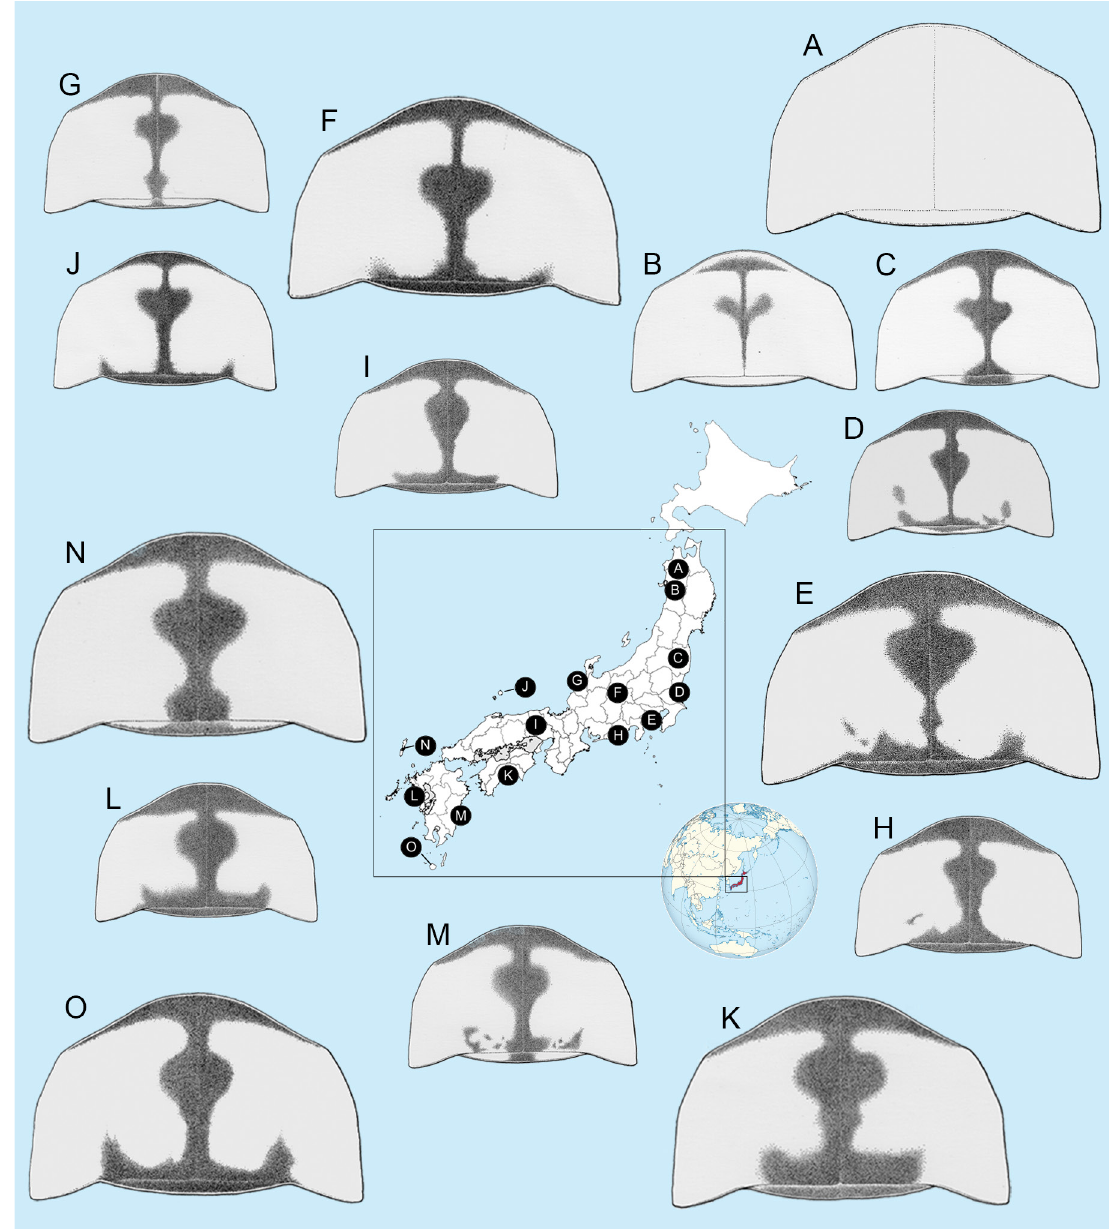
Fig. 6. Distribution of pronotal marking patterns of Nipponoluciola cruciata (Motschulsky, 1854) gen. et comb. nov. in the Japanese islands. Images by I. Kawashima. Map by W.F.A. Jusoh (map of Japan using base maps obtained from Wikimedia Commons - Maximilian Dörrbecker and Connormah, CC BY- SA 3.0). Not to scale. Figure legend: A . Aomori (based on Nakane 1987). B . Akita. C . Fukushima. D . Ibaraki. E . Kanagawa. F . Nagano. G . Ishikawa. H . Shizuoka. I . Hyogo. J . Oki Islands. K . Kochi. L . Nagasaki. M . Miyazaki. N . Tsushima Island . O . Yakushima